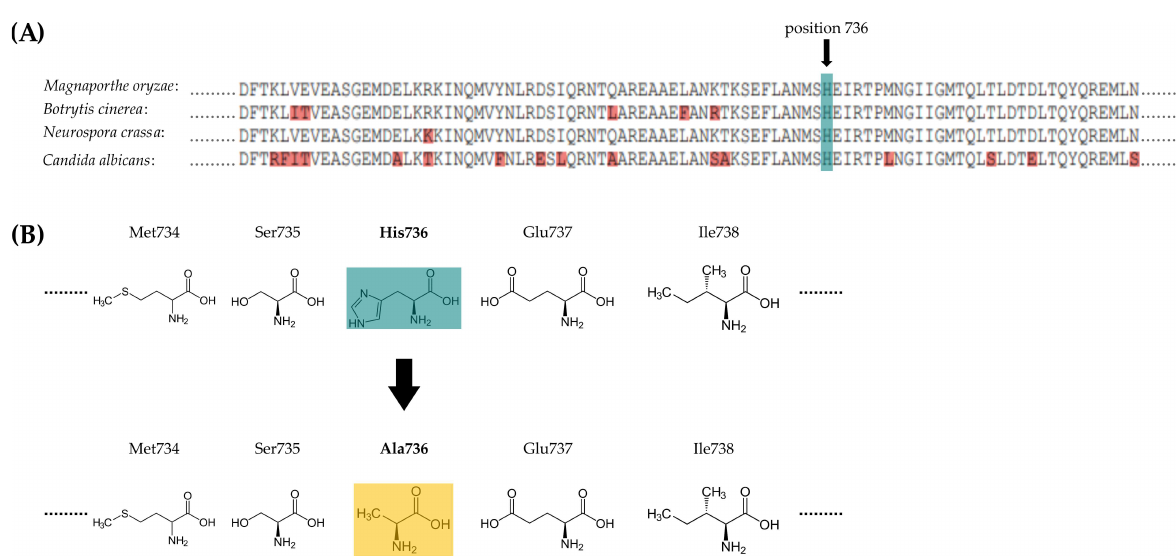
Figure 1. ( A ) Comparison of a protein sequence from the HisKA domain of the group III HK in different fungi. The putative histidine phosphotransfer sites are highlighted in blue. The differences between the sequences are highlighted in red. ( B ) Schematic illustration of the amino acid exchange from histidine (blue) to alanine